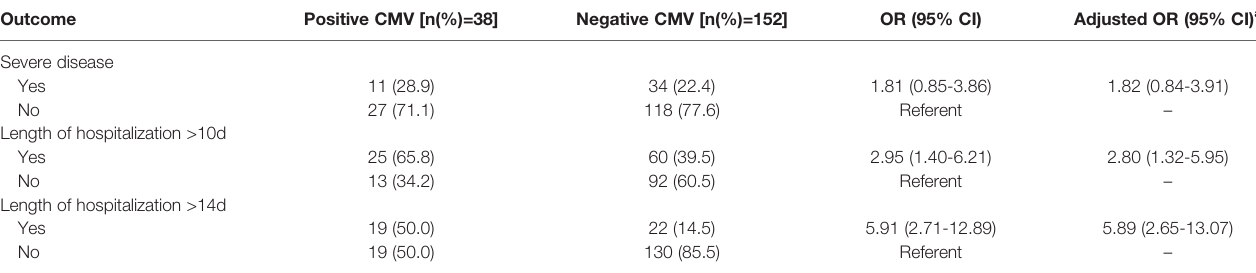
TABLE 4 | Associations of cytomegalovirus (CMV) PCR results in plasma with clinical outcomes, multiple logistic regression analysis. Outcome